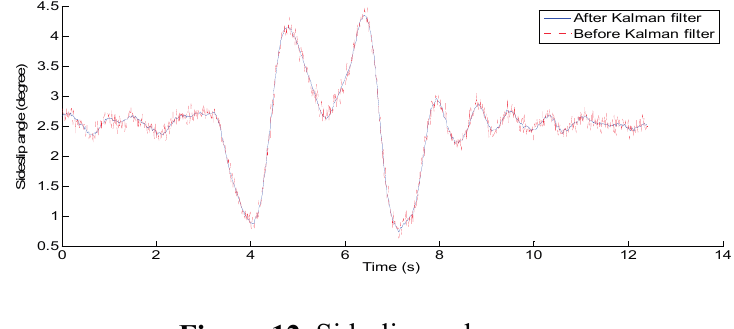
Figure 12. Sideslip angle curve.